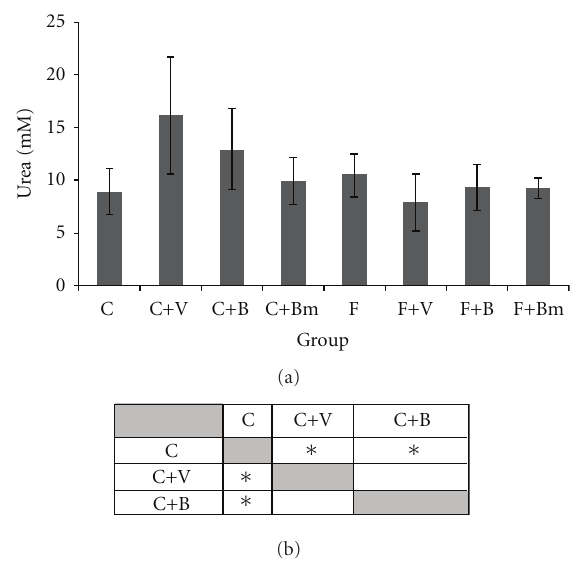
Figure 5: E ff ects of vanadium complex V, B, and Bm on plasma urea of Wistar rats. Data are presented as mean ± SD for n = 6. (b) Statistical di ff erences between groups P <